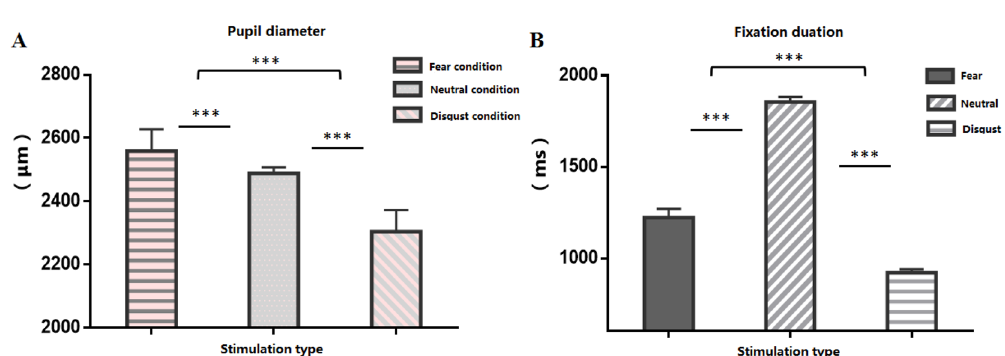
Figure 4. ( A ) The differences in pupil sizes between fear and disgust. ( B ) The fixation duration differences between fear and disgust. *** p < 0.001. Error bars represent standard mean